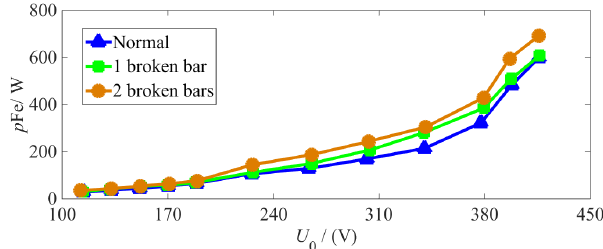
Figure 20. Characteristic curve of iron loss under no-load conditions.